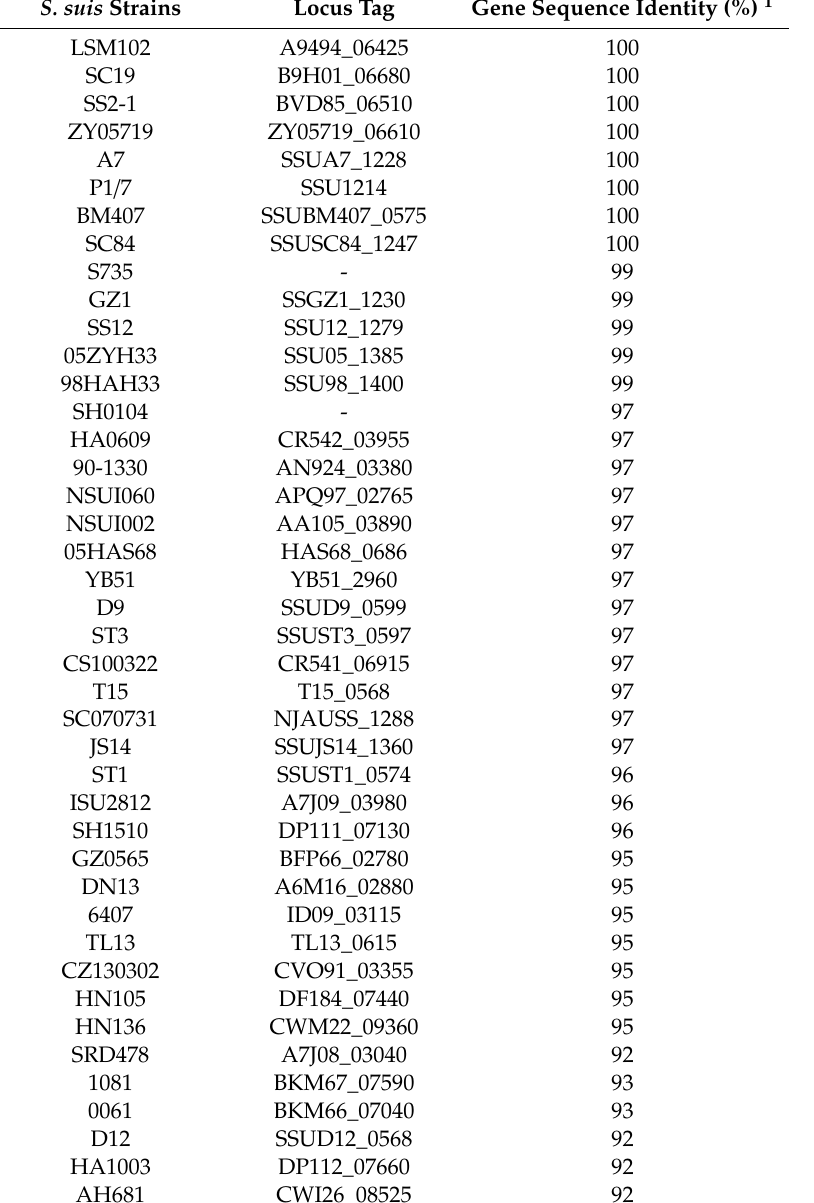
Table 1. Sequence identity of the copA gene in S. suis